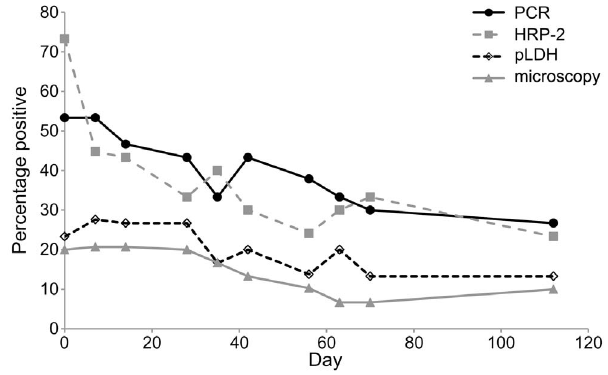
Figure 1. Trends in malaria prevalence by diagnostic method among the study participants that did not develop clinical malaria during the 112-day study. At every visit, malaria prevalences are highest when detected by Pf HRP-2 ELISA and qRT- PCR methods and lowest when measured with microscopy and p LDH